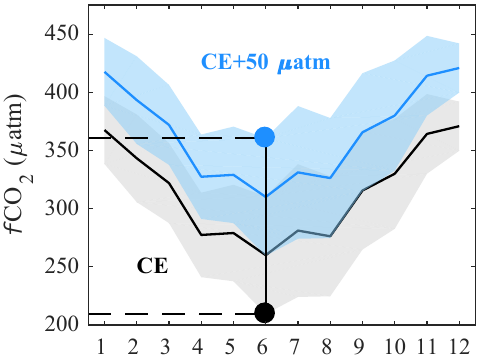
Figure 7. Schematic showing the Cape Elizabeth (CE) mooring monthly mean f CO 2 seasonal cycle (black) and the seasonal cy- cle + 50µatm (blue), which is meant to reflect an anomalous year. Black and blue shading are identical in magnitude and show the mean standard deviation (m σ ). The filled circles show two hypo- thetical discrete samples collected during June of each